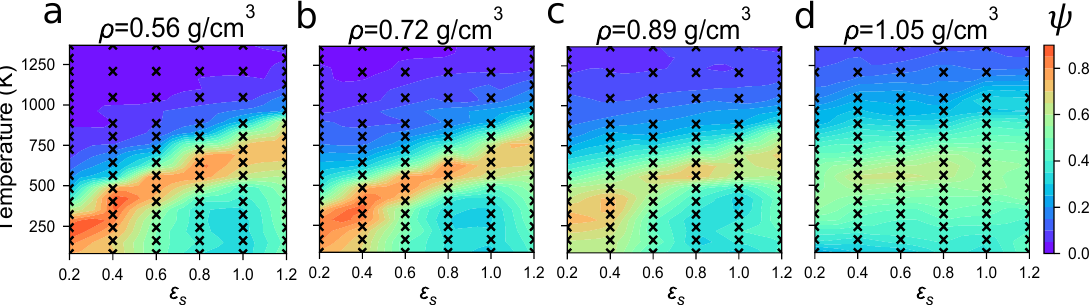
Figure 3. The degree of ordering, ψ , for Protocol (1) shows the most robust assembly occurs at lower densities, with more temperature-solvent combinations resulting in high ψ . ( a ) ρ = 0.56 g/cm 3 ; ( b ) ρ = 0.72 g/cm 3 ; ( c ) ρ = 0.89 g/cm 3 ; ( d ) ρ = 1.05 g/cm 3 . Red regions denote order, whereas blue denotes disorder. Each black “x” indicates a measurement from an MD trajectory, and ψ values between measurements are linearly